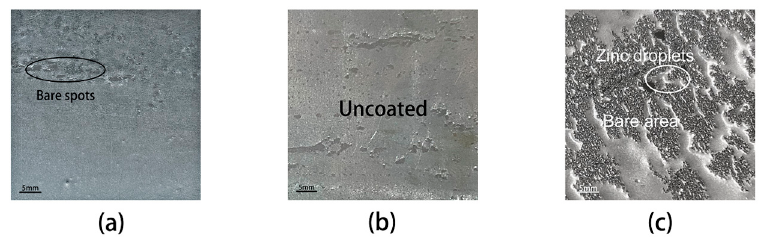
Figure 4. The surface of hot-dip galvanized samples annealed at different dew points. ( a ) 4# ( − 50 °C), ( b ) 5# ( − 10 °C), ( c ) 6# (+10 °C).